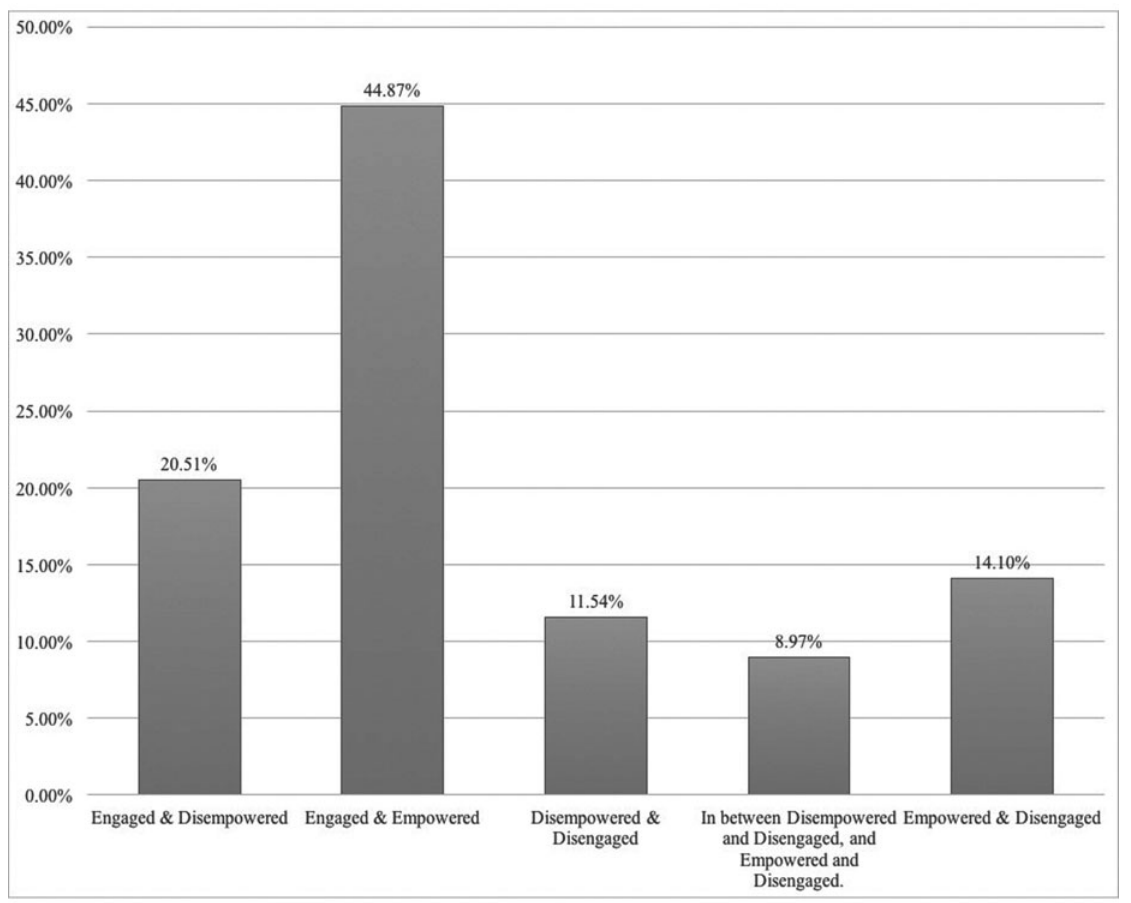
FIGURE 2 Feelings of Engagement and